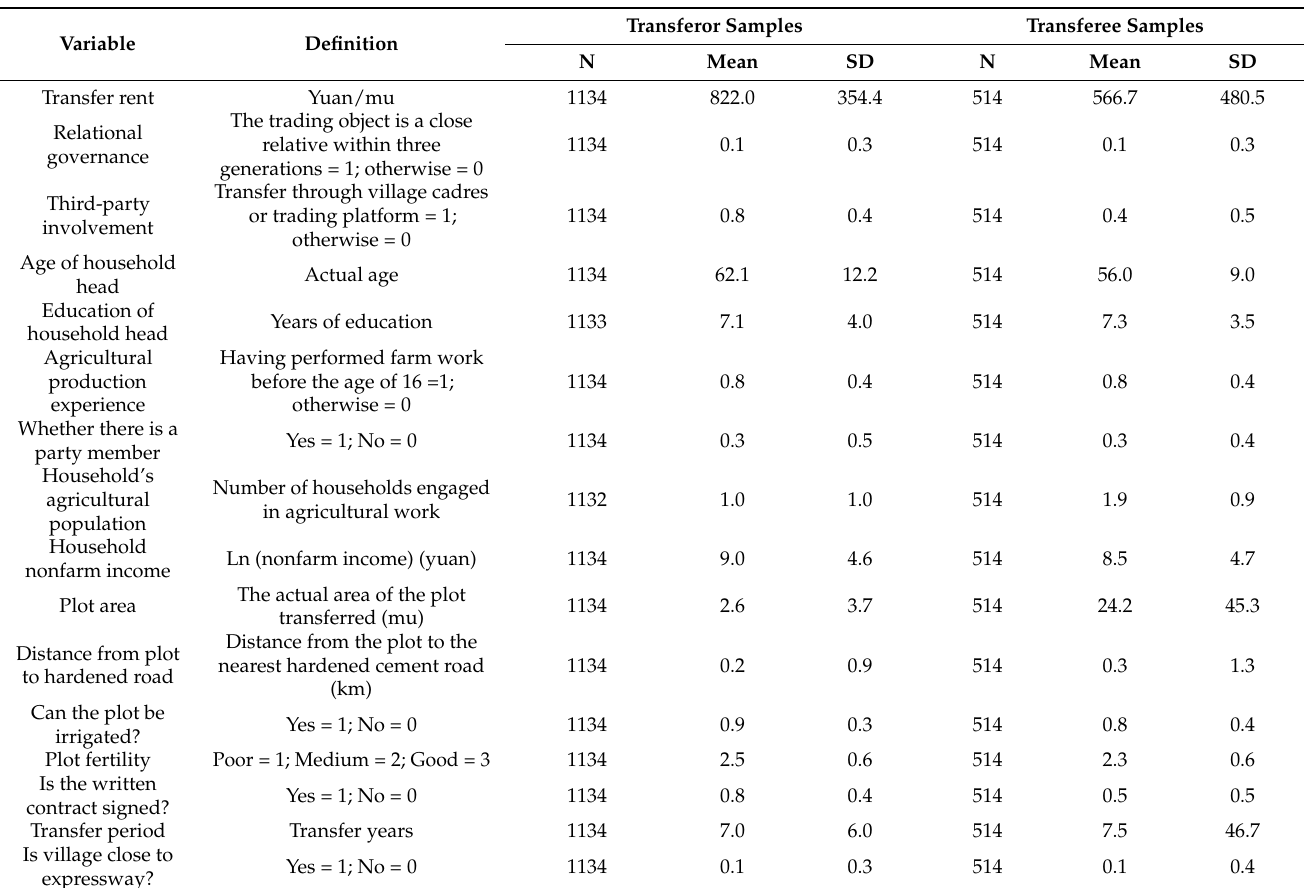
Table 1. The definitions and descriptive statistics of the survey